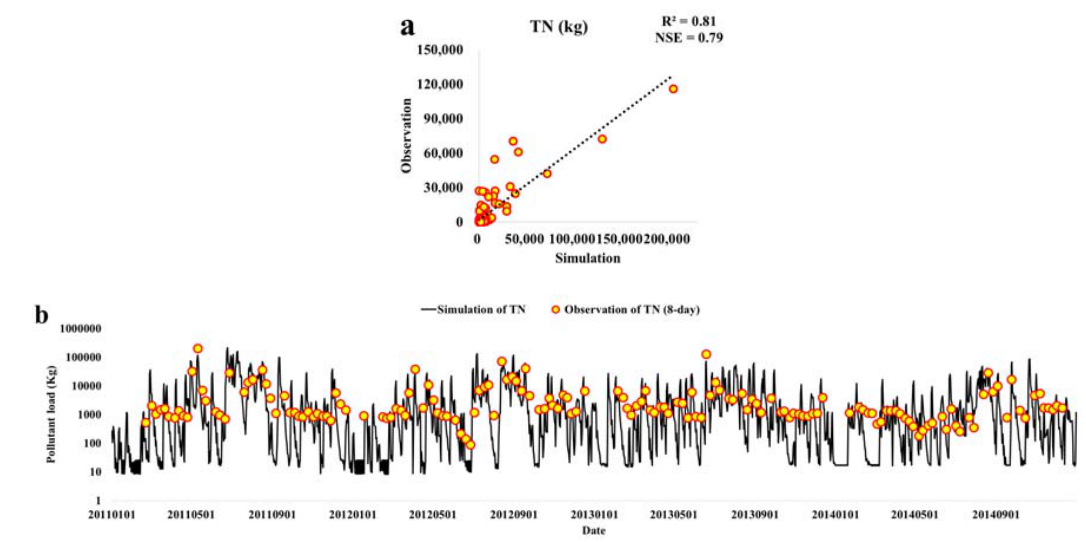
Figure 5. Comparison between simulated streamflow ( a ) and observed streamflow ( b ) at Pyungchang A watershed (2011–2014).